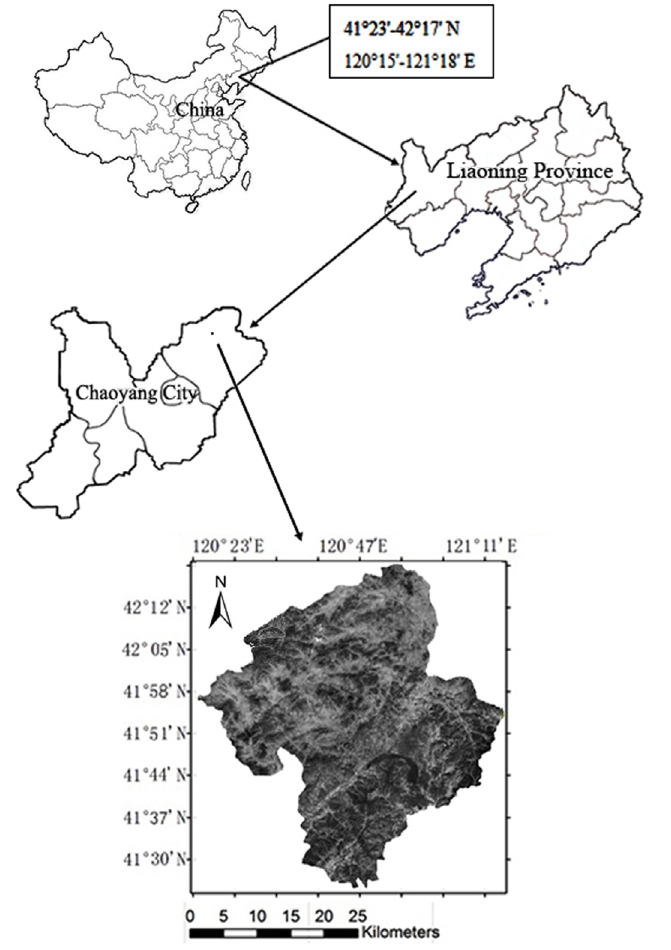
Fig 1. Map of the location of the study